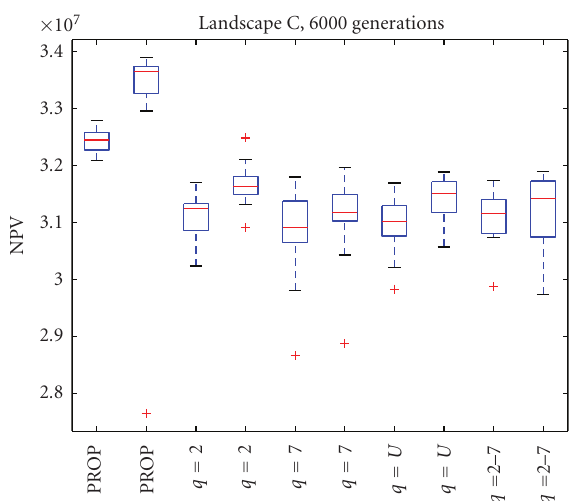
Figure 6: Results for Landscape C, 6000 generations. This figure presents a box-plot of solution quality (NPV; y -axis) for each paired selection/penalty strategy tested. The x -axis displays the strategy; static and dynamic penalty strategies for the same selection strategy are displayed side by side (static on the left side). Reading from left to right, the first selection strategy presented is proportional selection and the rest are deterministic tournaments with various competitor pool sizes ( q ). The label “ q = U ” corresponds to the strategy wherein q was sampled from a uniform distribution over the range (2, 10), and the label “ q = 2–7” corresponds to the strategy where q increased from 2 to 7 during the search.